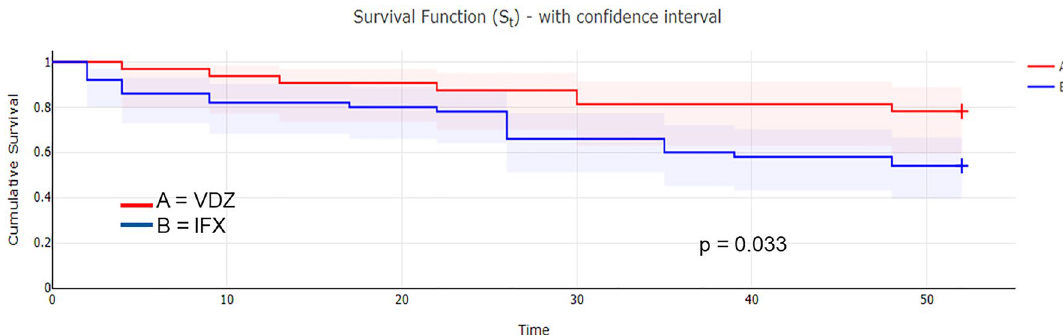
Figure 2. Drug persistency of Infliximab (IFX) and Vedolizumab (VDZ) according to Weighted Kaplan–Meier analysis at 52 weeks.